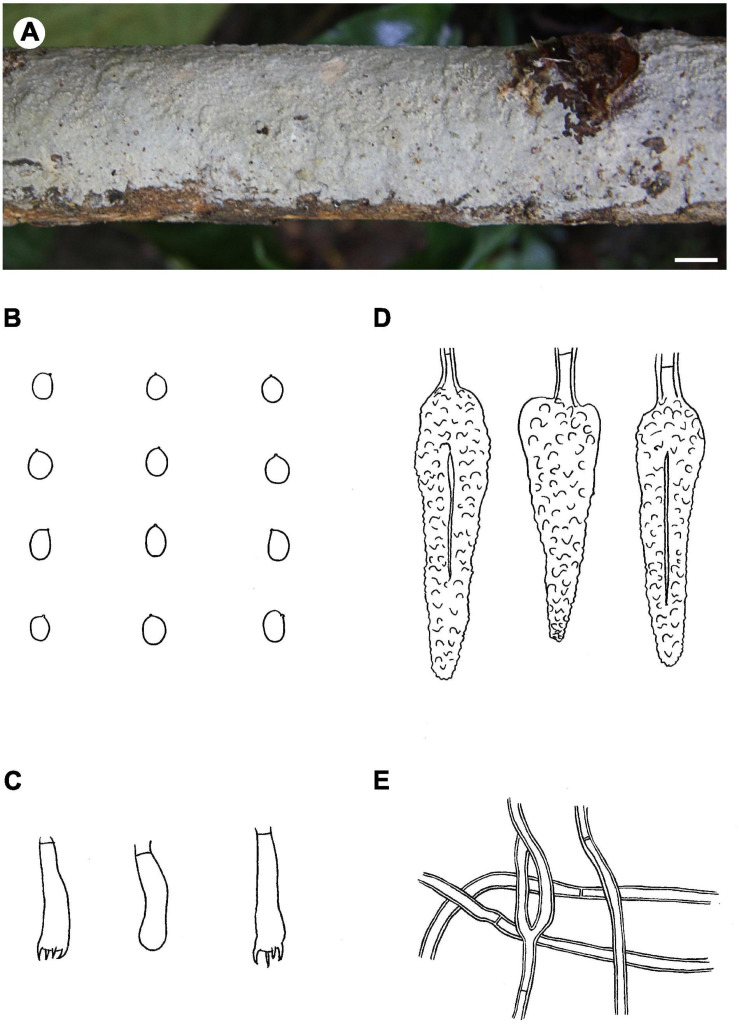
Phlebiopsis magnicystidiata (A from He 20140719-18, B–E from the holotype He 5648; scale bars: A = 1 cm, B–E = 10 μm). (A) Basidiomata; (B) basidiospores; (C) basidia and basidiole; (D) lamprocystidia; (E) hyphae from subiculum.